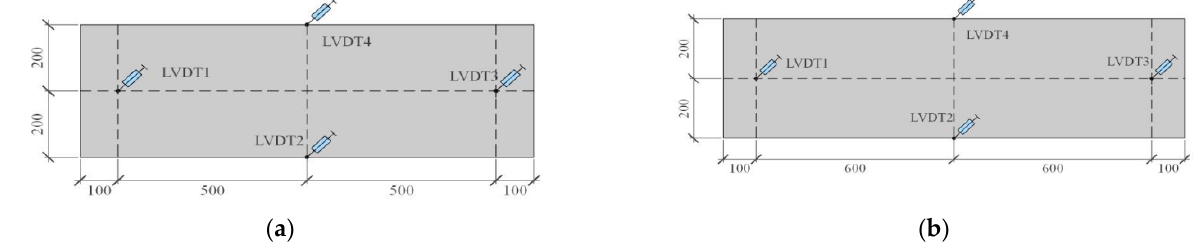
Figure 6. Arrangement of LVDTs on specimens (unit: mm). ( a ) Arrangement of LVDTs on SW2 and SW3; ( b ) Arrangement of LVDTs on SW4.